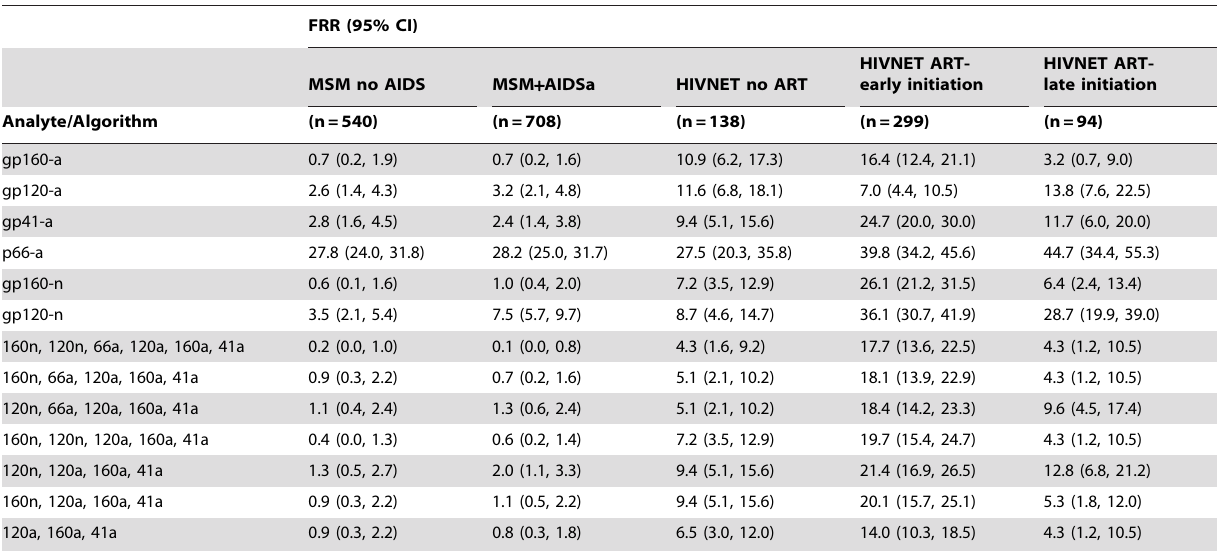
Table 2. Impact of disease progression and antiretroviral use on false-recent rates.